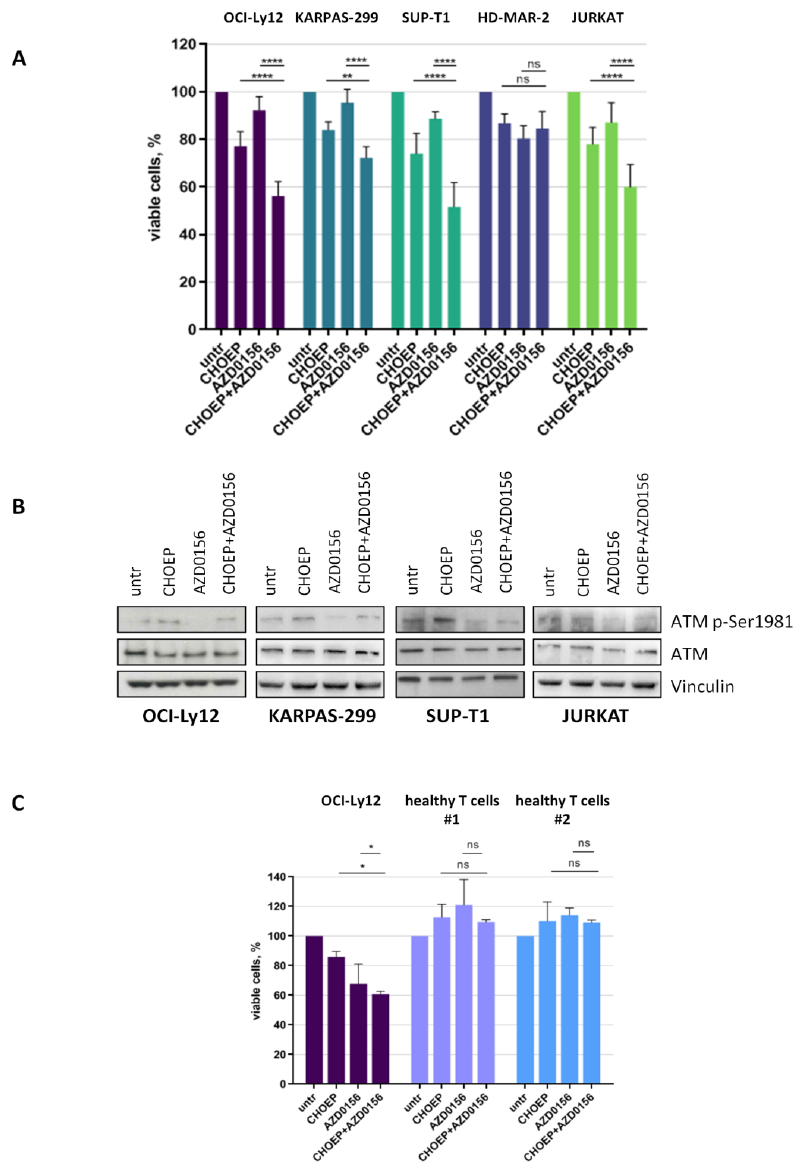
Figure 3. AZD0156 promotes CHOEP-induced reduction in cell viability in malignant T cell lines. The indicated cell lines were treated with IC 20 CHOEP and IC 20 AZD0156 alone or in combination for 48 h. Then cell viability was assessed by flow cytometry ( A ), and cell lysates were subjected to Western blot using the indicated antibodies ( B ). OCI-Ly12 and healthy T lymphocytes, isolated from the peripheral blood of two different healthy donors, were treated for 48 h with IC 20 CHOEP and IC 20 AZD0156 alone or in combination. Then viable cells were monitored by flow cytometry ( C ). In A and C, data are expressed as the percentage of untreated samples and are the mean ± SD of at least three independent experiments (* p < 0.05; ** p < 0.01; **** p < 0.0001; ns: not significant). To rule out the possibility that the different effects observed in the cell lines treated with either AZD0156 alone or the AZD0156 + CHOEP combination could be due to the presence of mutations in ATM and/or TP53 , we performed targeted sequencing analysis. As expected, all cell lines bear pathogenic TP53 alterations but no ATM mutations. ATM is mutated only in JURKAT cell line, but we were unable to define a clear inactivating effect of the detected alterations (Tables S2 and